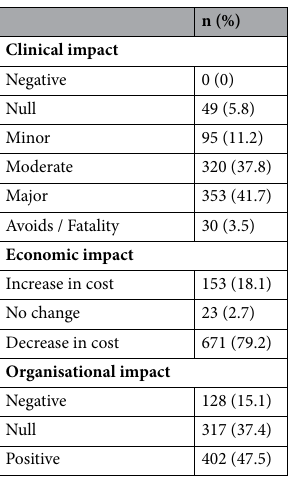
Table 3. Potencial clinical, economic and organisational impact of pharmacist interventions through CLEO tool.